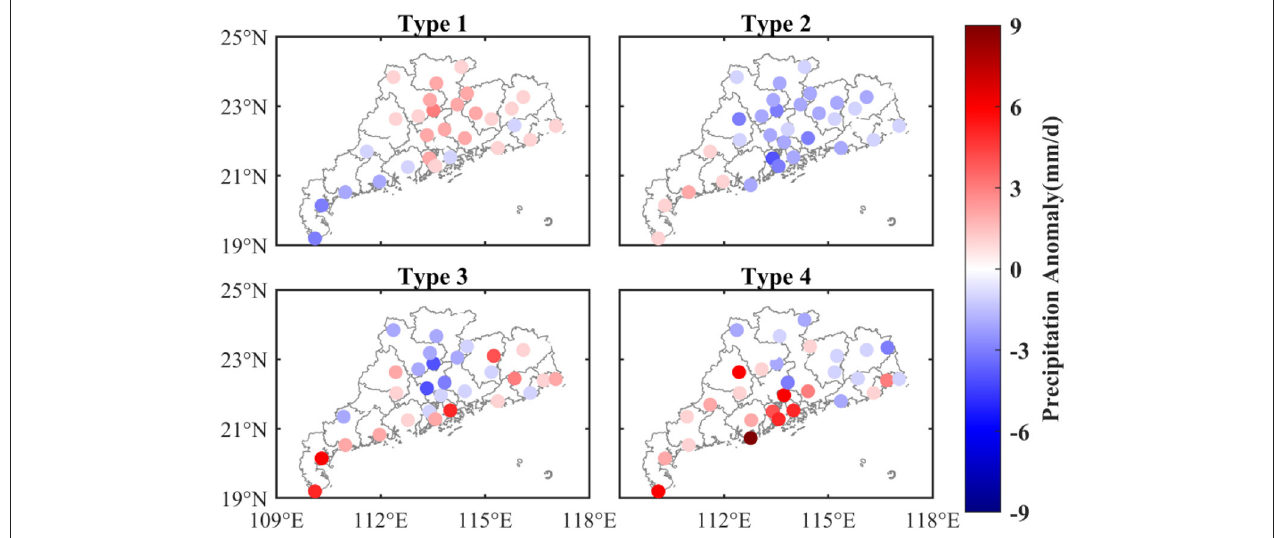
FIGURE 5 | Spatial distribution of summer daily precipitation anomaly under four weather patterns relative to summer mean values: (A) Type 1, (B) Type 2, (C) Type 3, and (D) Type 4.